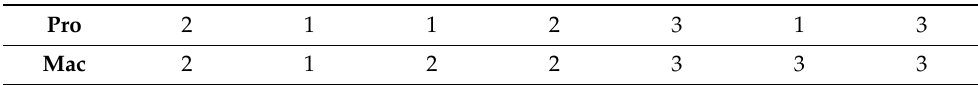
Table 2. A set of chromosome code representation instances.